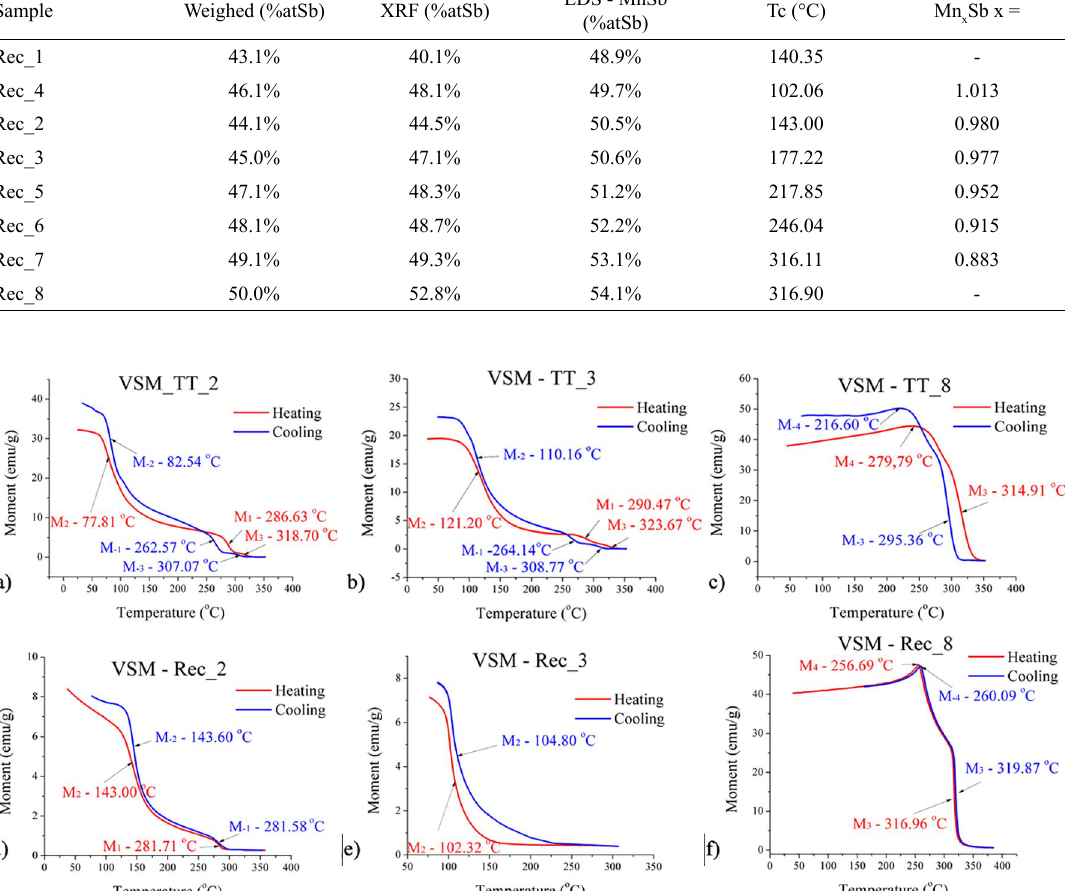
Sb phase correlated to Tc. x